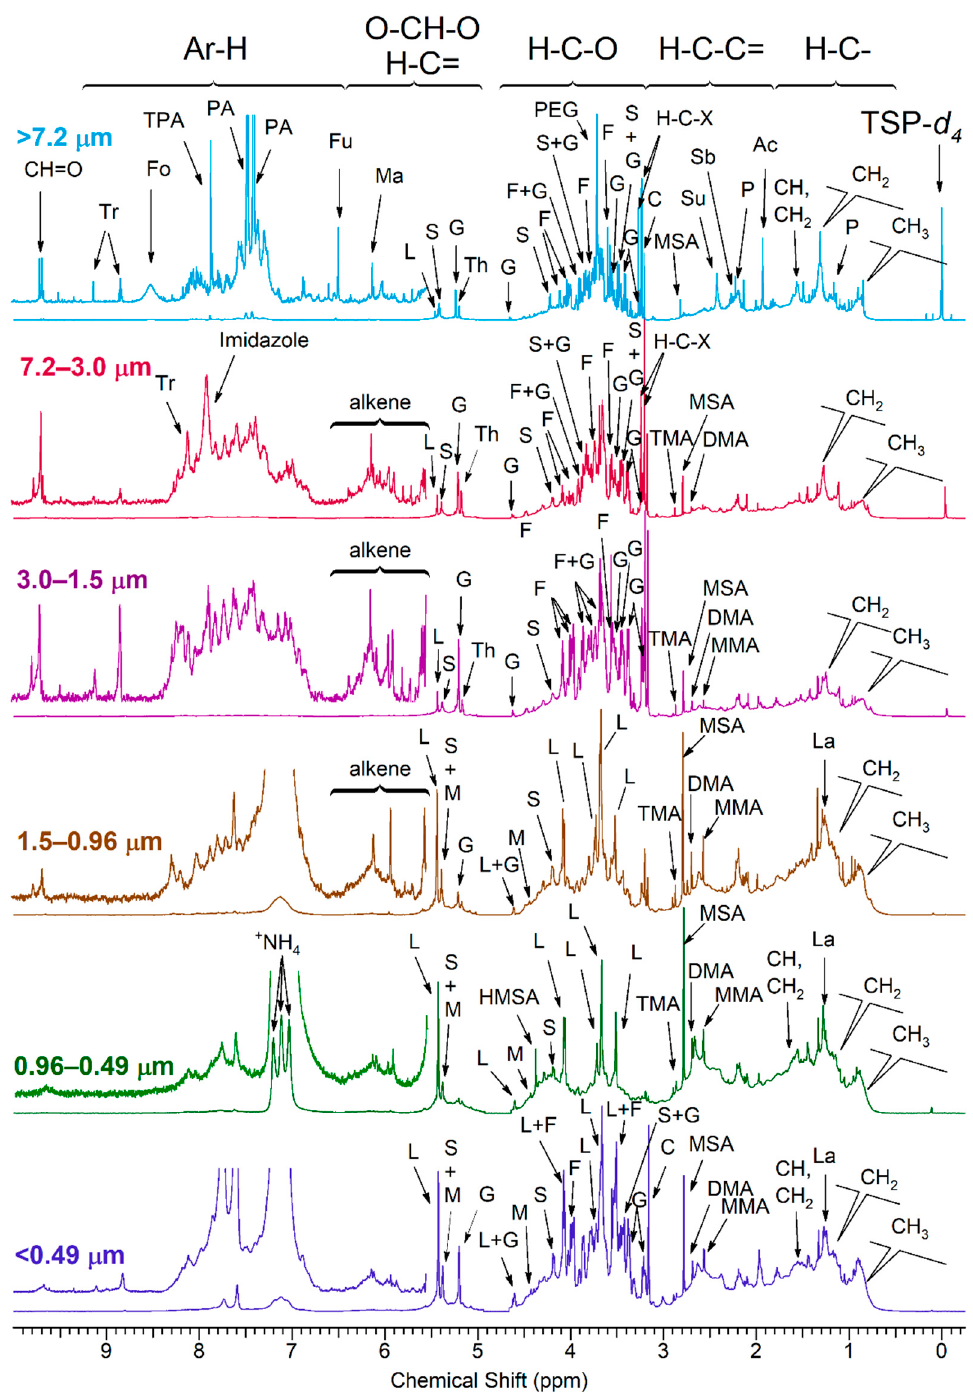
Figure 2. 600 MHz 1 H-NMR spectra of size fractionated water-soluble organic carbon (WSOC) in phosphate buffer 10% D 2 O (TSP-d4: internal standard). The segment from δ 4.5 to δ 5.0 ppm was removed from all NMR spectra due to H 2 O